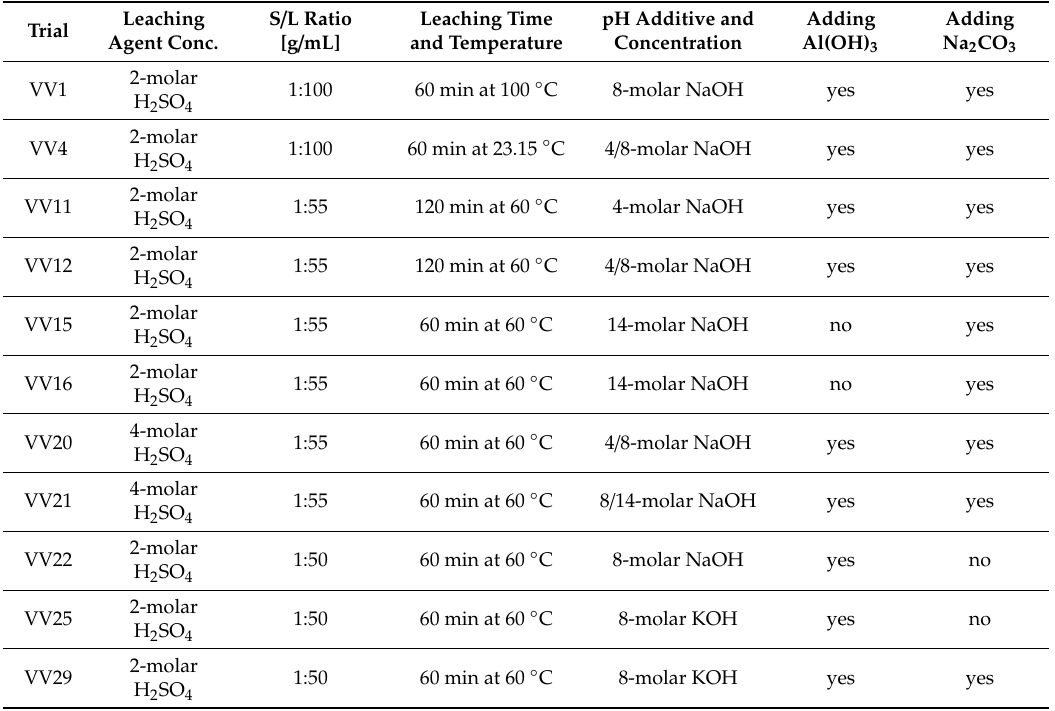
Table 4. H 2 SO 4 parameter combinations applied in the pre-trials. S / L represents the solid / liquid ratio applied, hence, black mass per leaching liquid.